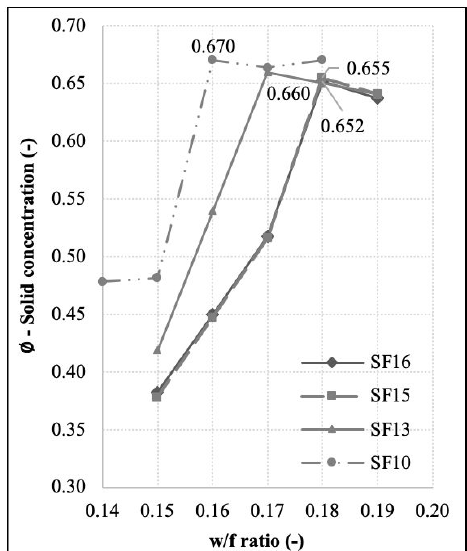
Figure 8. Solids concentration of the ternary pastes with PC, SP and SF.